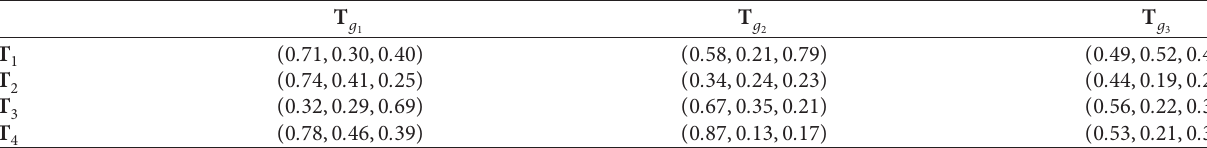
Table 3: Information given by senior experts in TSFSs.